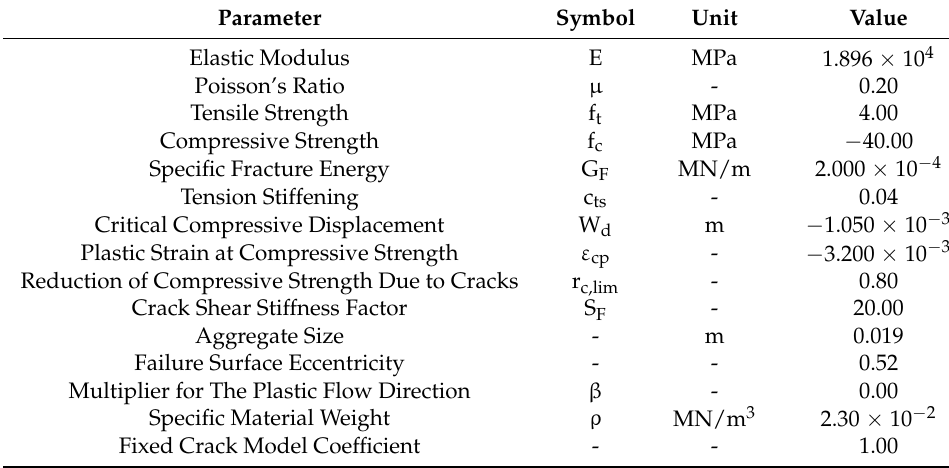
Table 5. Parameters of the concrete model.